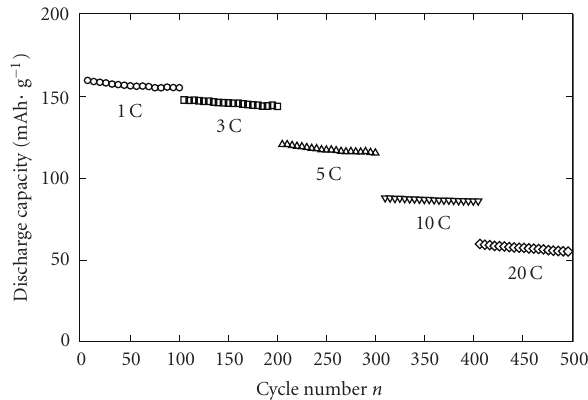
Figure 6: Relation between cycle number and discharge capacity of LiFePO 4 /C cathode at indicated discharge rate.